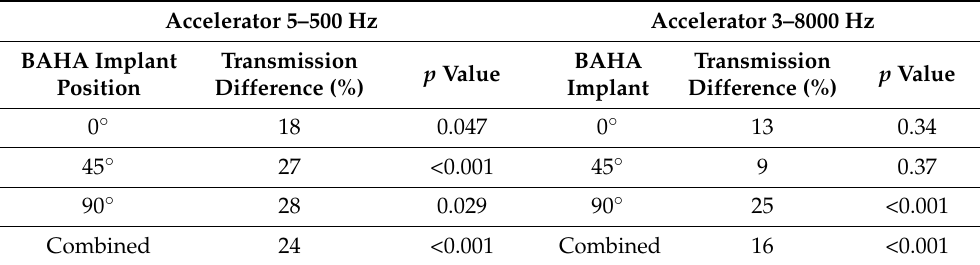
Table 1. Propagation properties of accelerators 5 and 3.